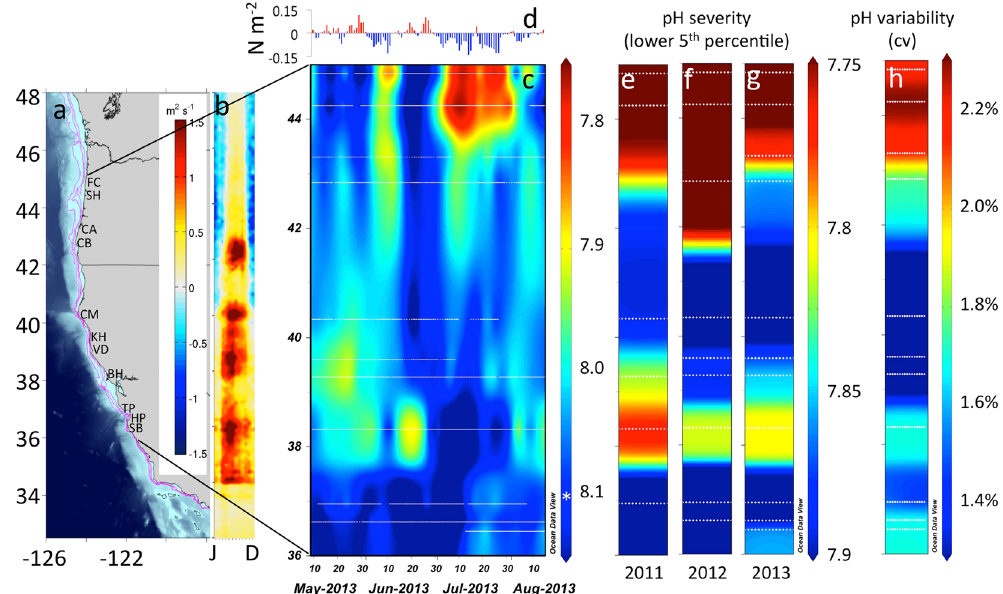
Figure 1. ( a ) Intertidal pH total variation across the CCLME study domain of contrasting shelf topography as delineated by the 75 m, 100 m, 200 m isobaths (magenta), and ( b ) wind-driven cross-shelf surface transport (m 2 s − 1 )(see scale inset in a). Map was generated from the ETOPO1 dataset 42 in Matlab v8.2 (http://www. mathworks.com/products/matlab). ( c ) Variation in pH at the event-scale during part of the 2013 upwelling season with asterisk denoting global mean surface pH 12 and ( d ) accompanying daily wind stress (N m − 2 ) at 44.65°N, ( e – g ) severity of low pH exposure (lower 5 th percentile) across three years of deployment and ( h ) pH variability. White dotted lines in pH panels denote station